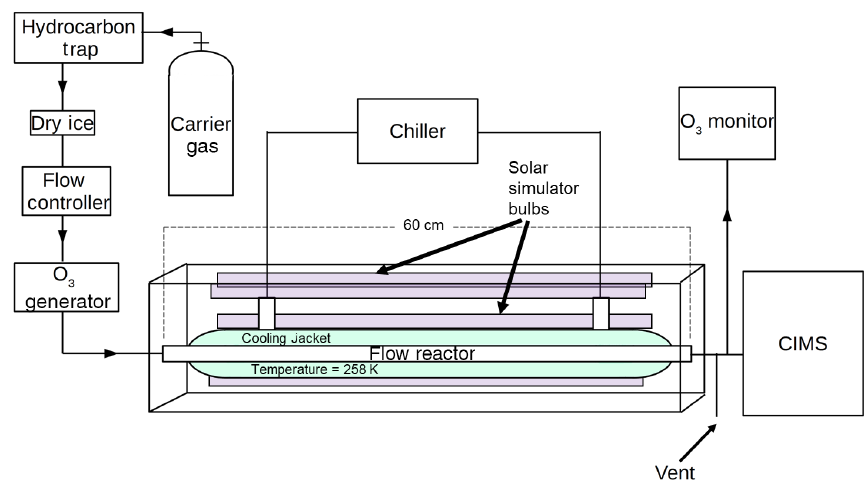
Figure 1. Experimental schematic. Purple bars represent powered solar simulator bulbs. The green shading around the flow tube (flow reactor) represents cooling liquid (60% ethylene glycol, 40% water) circulated through the chiller. The flow reactor region itself has an inner diameter of